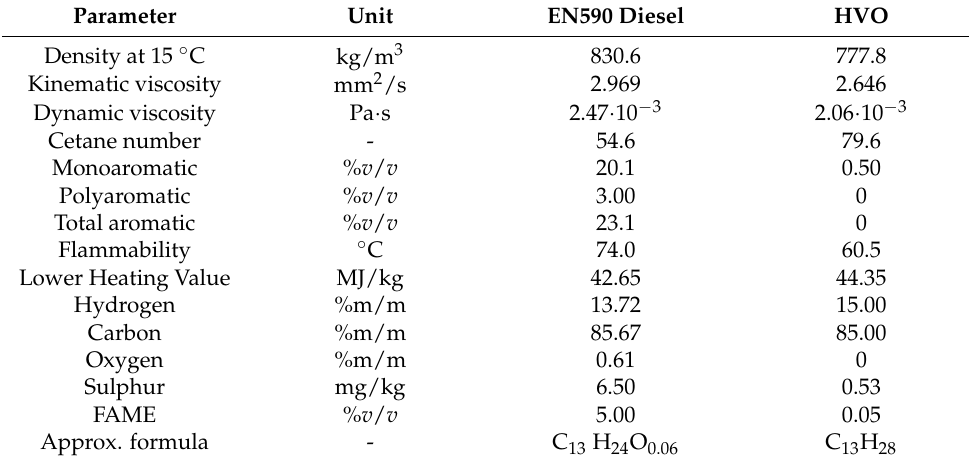
Table 2. Diesel vs. HVO main